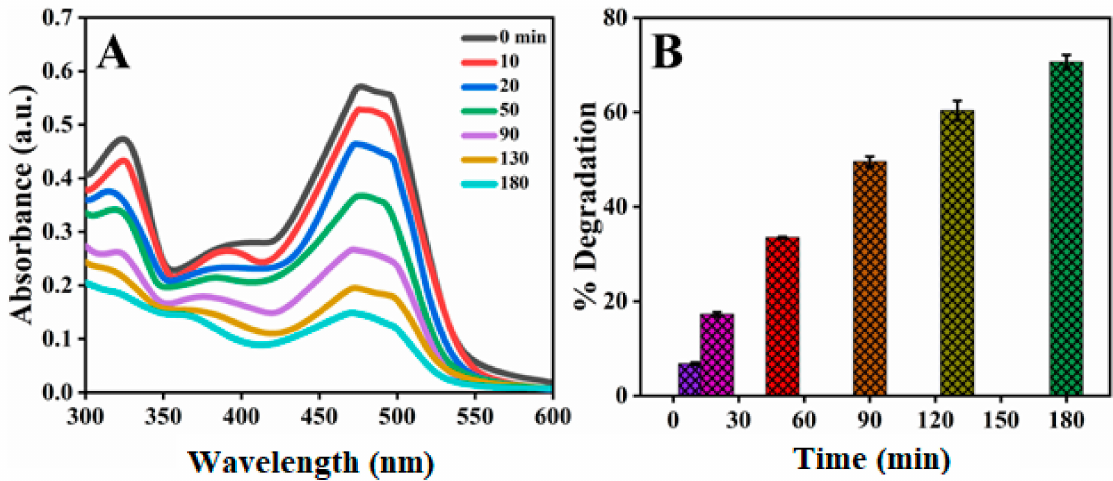
Figure 11. ( A ) Absorbance spectra of Orange G (15 ppm) dye at different time intervals, ( B ) Percentage degradation of Orange G dye at different time intervals.